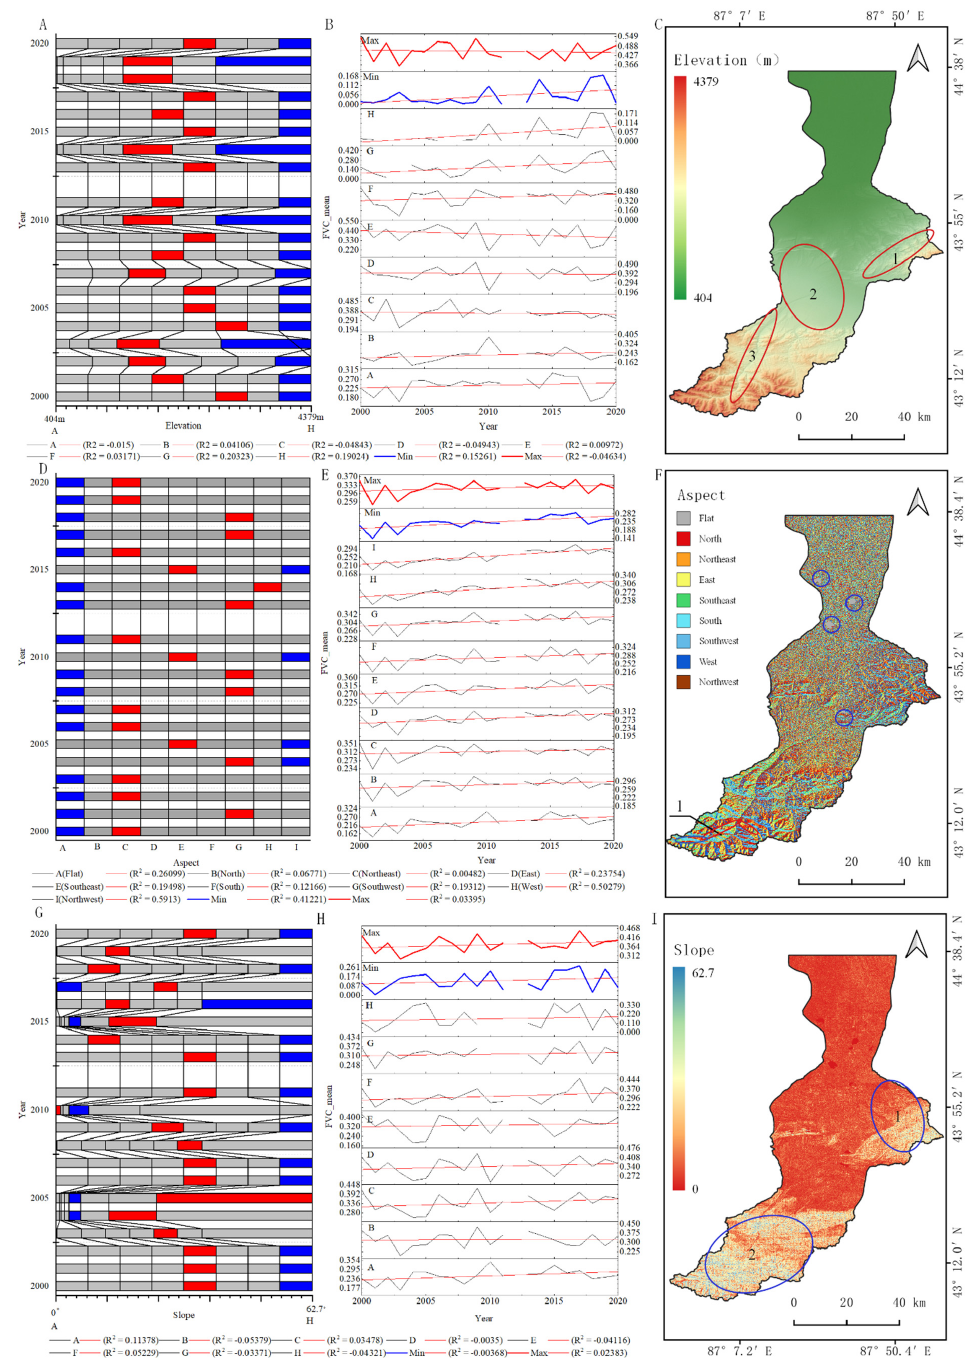
Figure 11. Analysis of the terrain characteristic risk area based on the OPGD model: ( A ) elevation risk areas; ( B ) FVC mean values for each elevation risk areas; ( C ) spatial distribution of elevation; ( D ) aspect risk areas; ( E ) FVC mean values for each aspect risk areas; ( F ) spatial distribution of aspect; ( G ) slope risk areas; ( H ) FVC mean values for each slope risk areas; ( I ) spatial distribution of slope; (red line) maximum FVC mean value in risk area; (blue line) minimum FVC mean value in risk